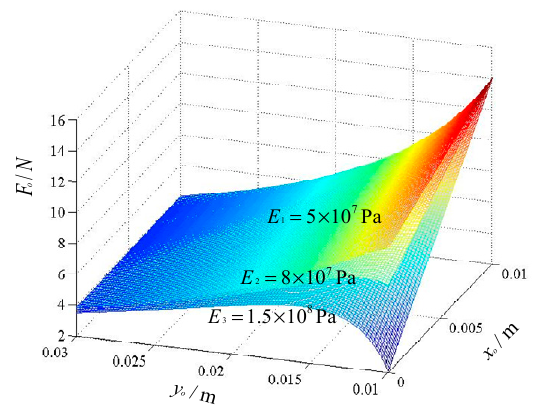
Figure 11. Influences of x o , y o , and E on F o ( r = 0.02 m, R o = 0.01 m, l = 0.03 m, r p = 0.003 m, N = 12, p o = 1.01 × 10 5 Pa, and p i = 0.8 p o ).